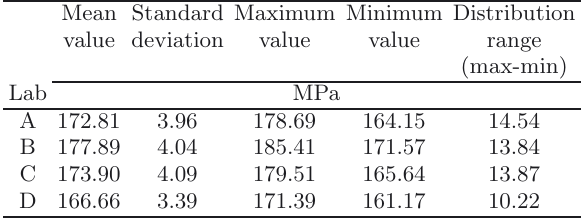
Fig. 2. The photo during tests. Including sample, grips, ex- tensometer and force transducer. Table 2. Distribution ranges of tensile strengths ( σ t ) for the participant